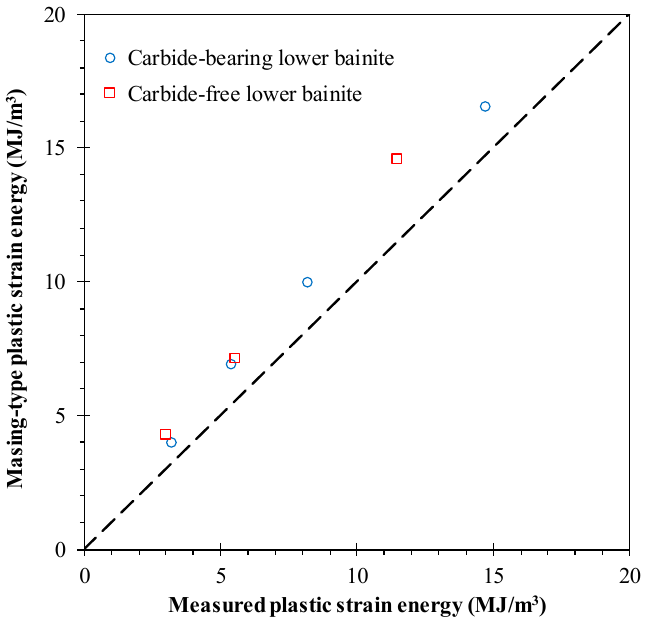
Figure 9. Comparison of the experimentally measured plastic strain energy densities ( Δ W p ) and the ideal Masing-type plastic strain energy densities ( Δ W pM ).